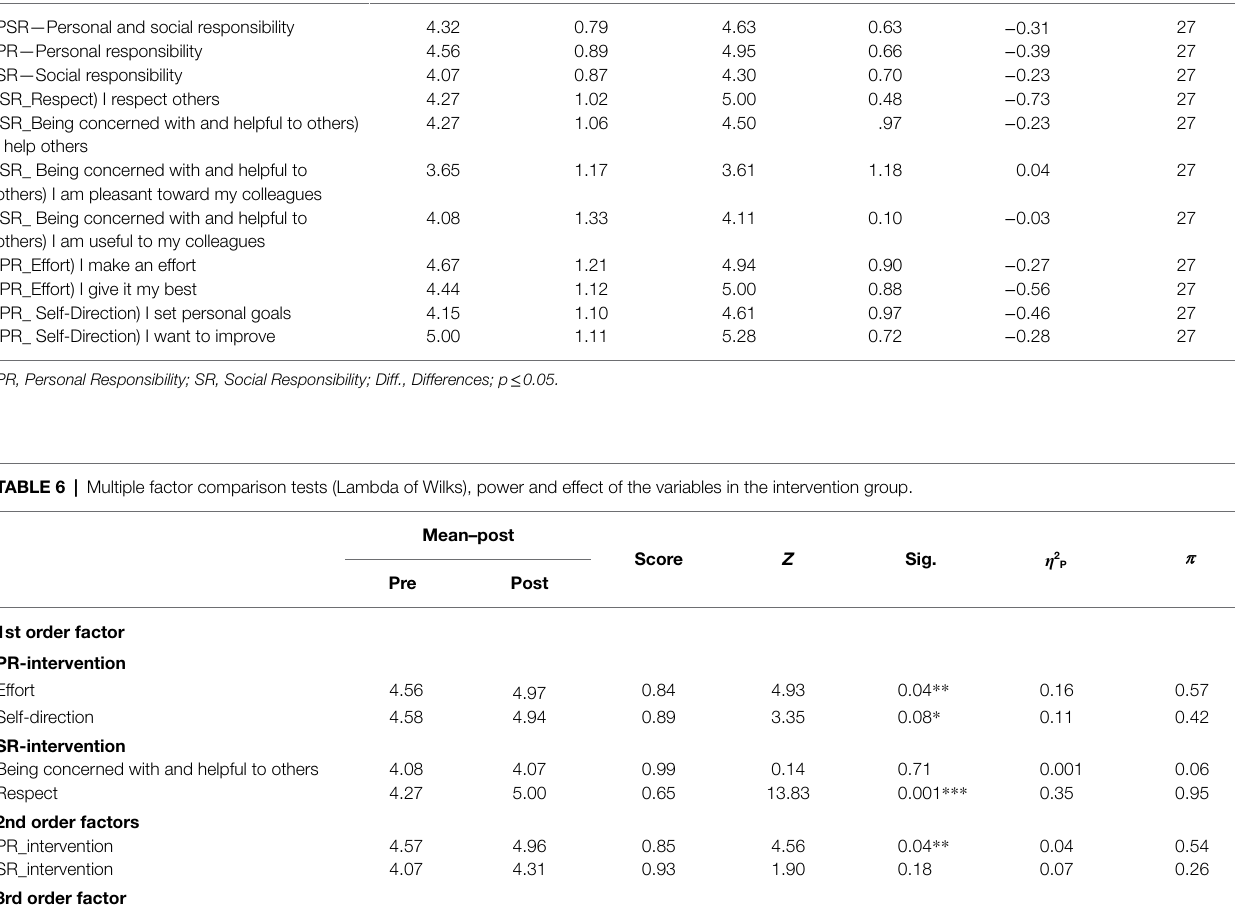
Before After Mean SD Mean